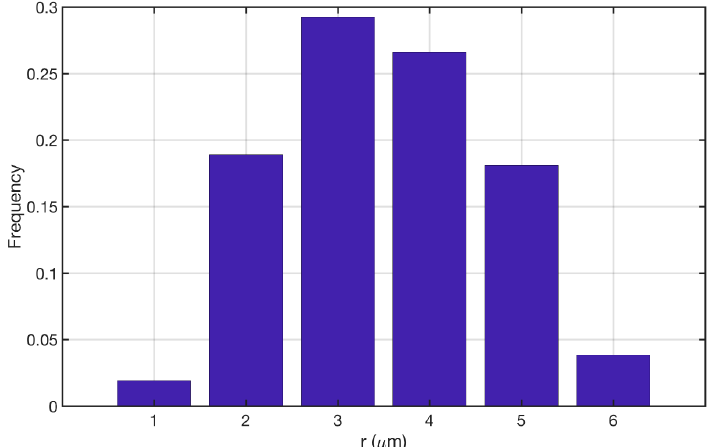
Figure 4. Pore size distribution of the reconstructed catalyst for the present study.